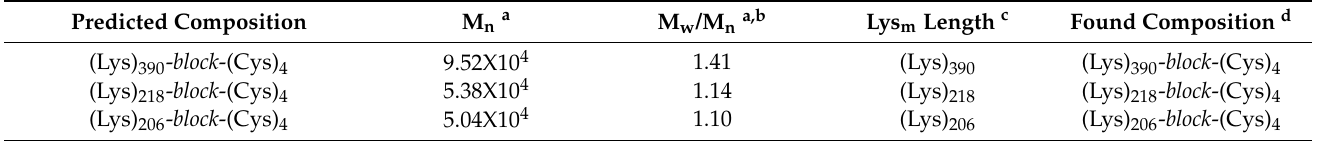
Table 4. Properties of the diblock copolypeptide amphiphiles synthesized in this work. Predicted Composition